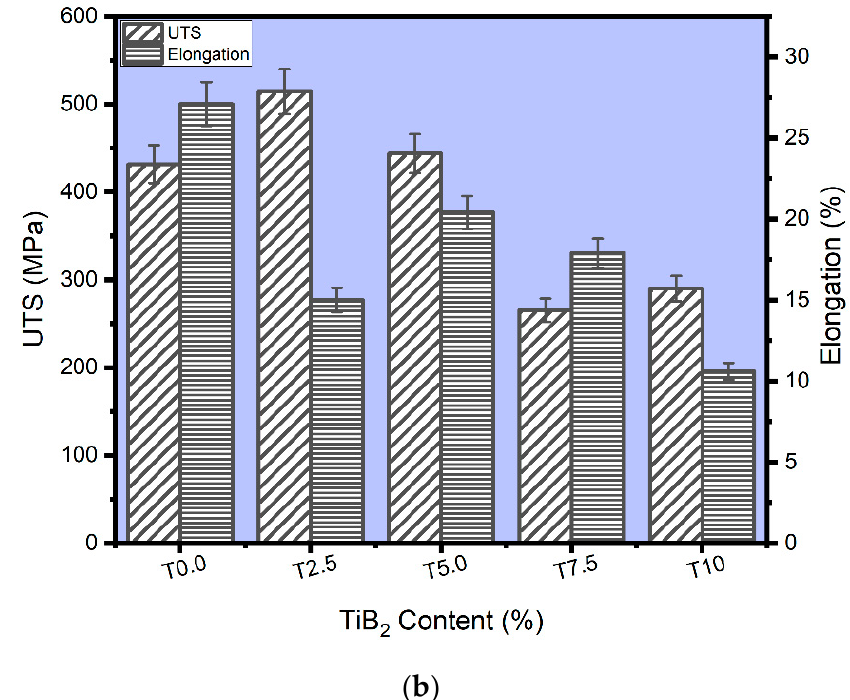
Figure 8. ( a ) The stress-strain curve of the sintered samples. ( b ) The UTS and Elongation plot of the sintered samples.